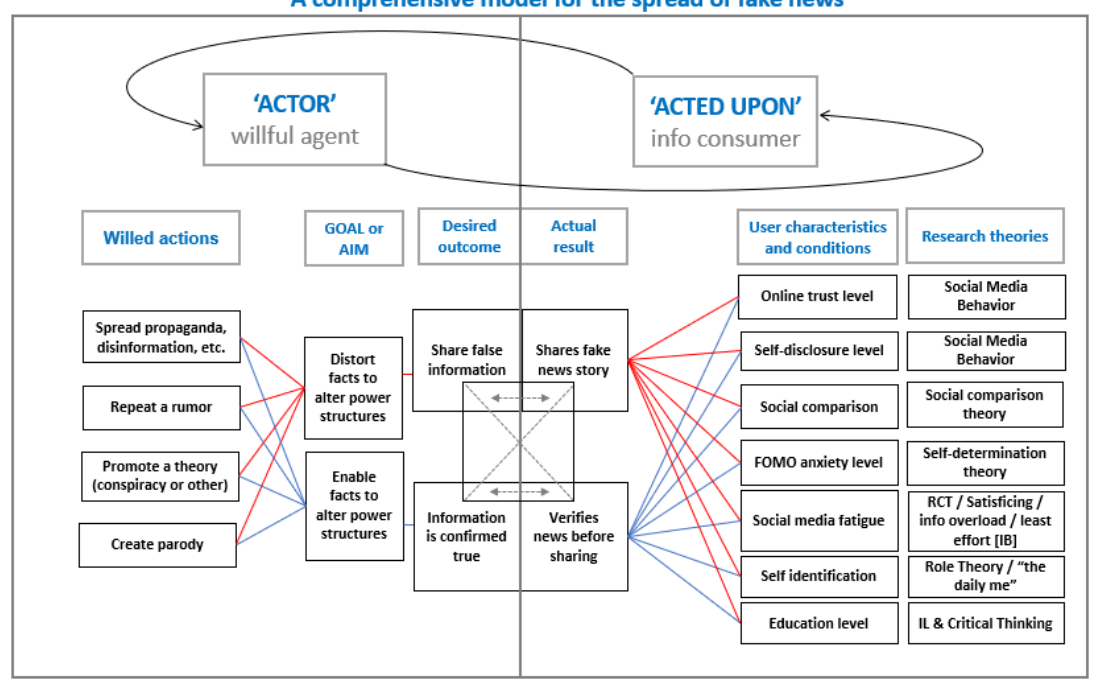
Figure 1. A comprehensive model for the spread of fake news, showing dual actor/acted-upon relationship; available at this url: http://scholarworks.csun.edu/handle/10211.3/218953, accessed on 6 July 2021. [License: Attribution-ShareAlike 4.0 International (CC BY-SA 4.0)].